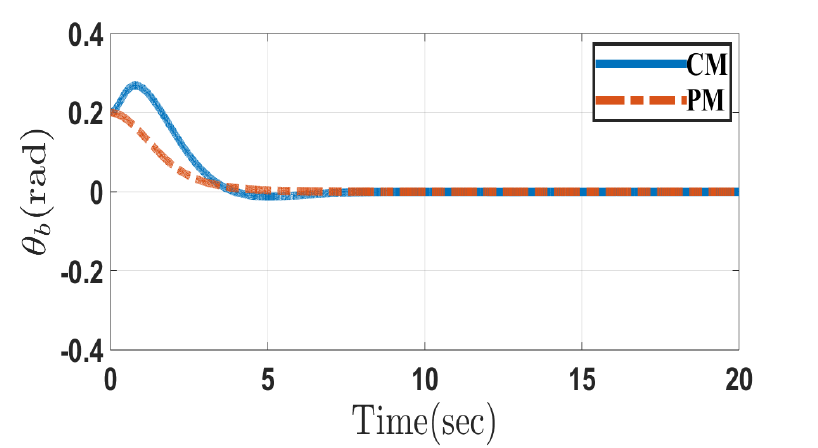
Figure 2. Pitch angle of the system in the conventional method (CM) and proposed method (PM) in Case 1.